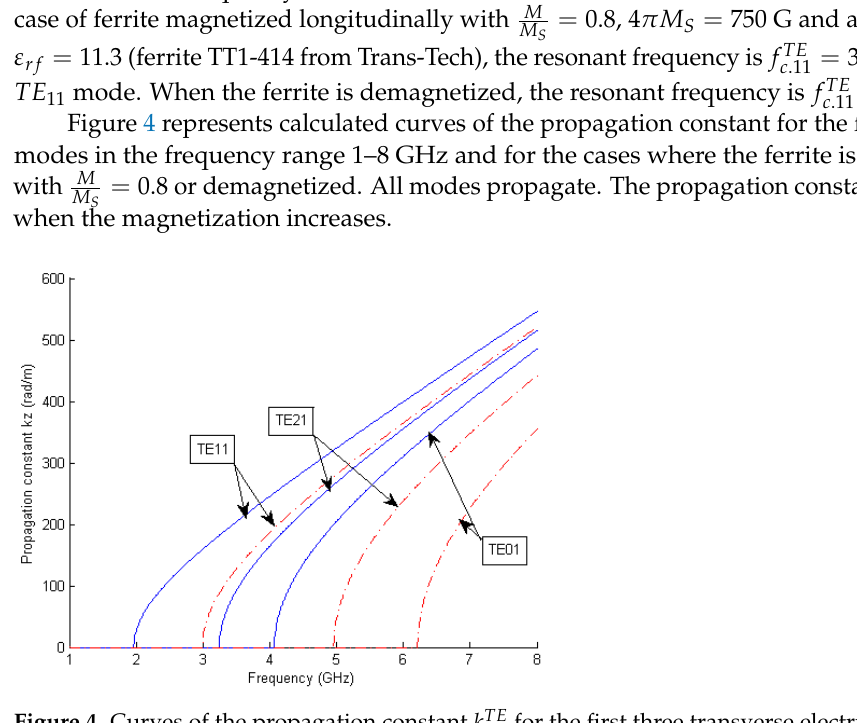
Figure 5. The cutoff frequencies for the first three TE modes vs.